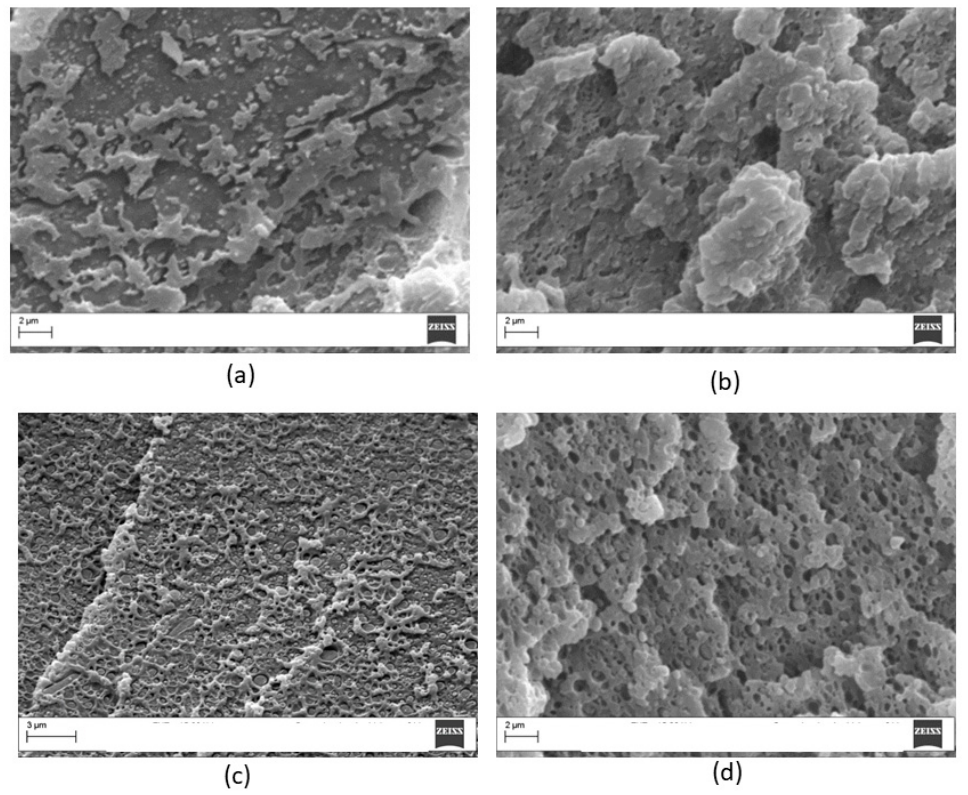
Figure 11. Micrographs of crio-fractured PEI/PC blends containing 20 wt % of PC for different etching time (magnification 10,000×): ( a ) 5 min; ( b ) 10 min; ( c ) 15 min; ( d ) 20 min.